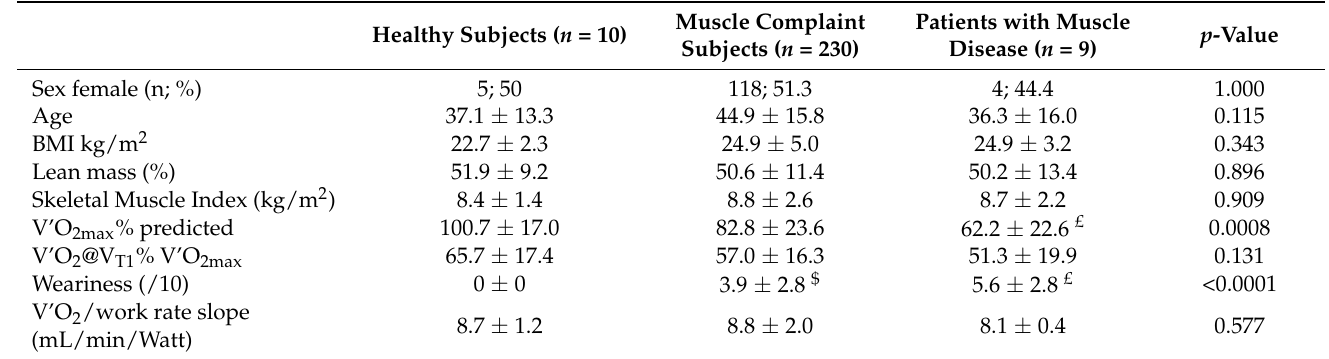
Table 3. Characteristics of healthy subjects, muscle complaint subjects and muscle disease patients. Healthy Subjects ( n = 10)